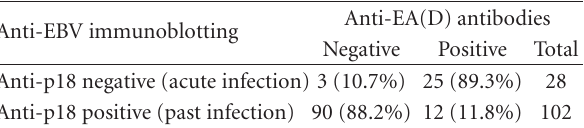
Table 2: Results of search for anti-EA(D) antibodies in relation to results of anti-EBV immunoblotting. Anti-EBV